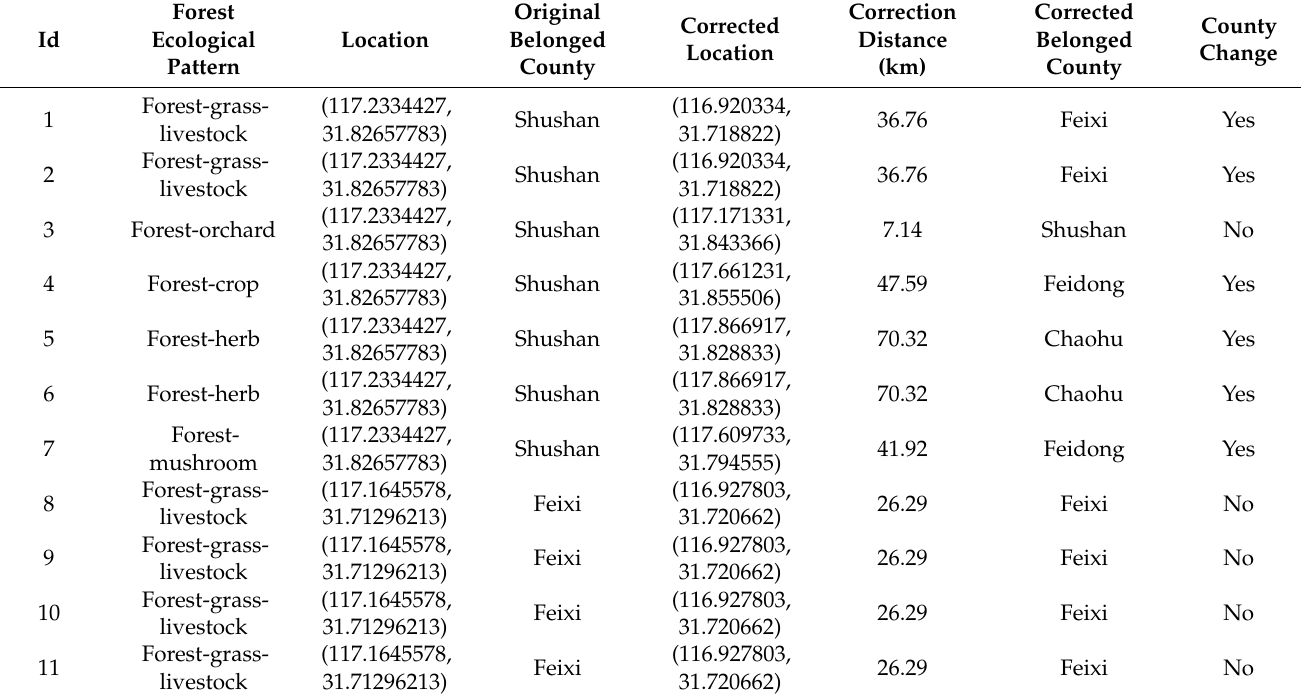
Table 3. Correction ranges of forest ecological patterns with the TC-RSI